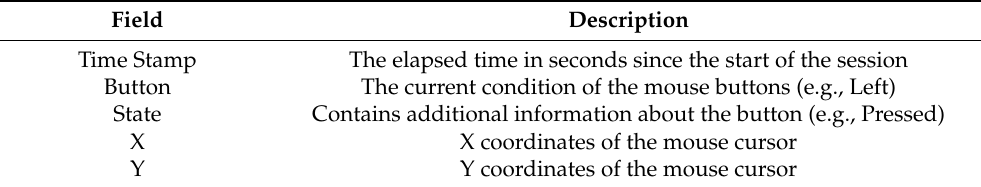
Table 1. Raw data